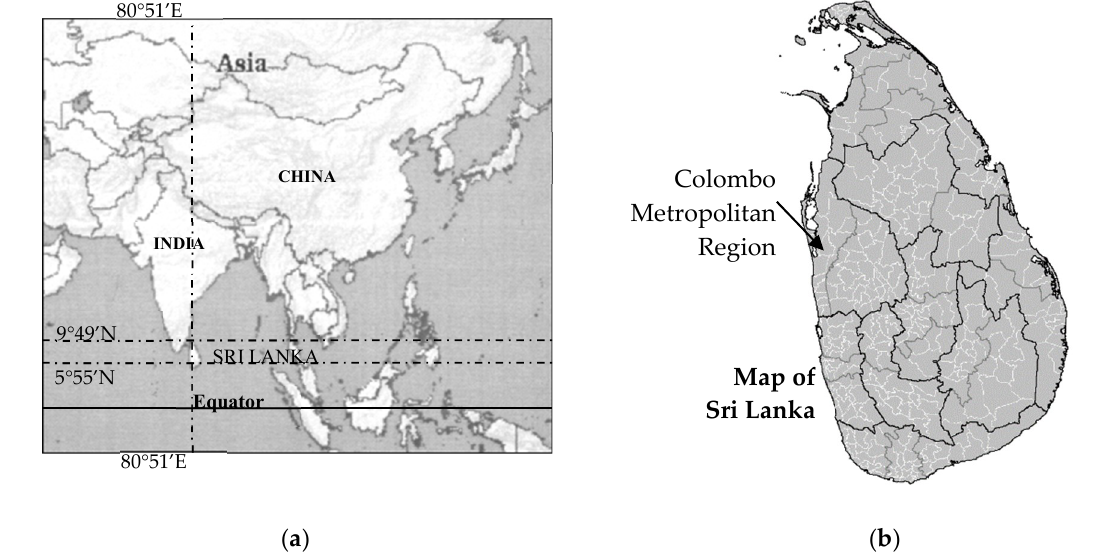
Figure 1. ( a ) Sri Lanka in the world map. It is situated between 9 ◦ 49’N and 5 ◦ 55’N of Equator. ( b ) Sri Lanka.